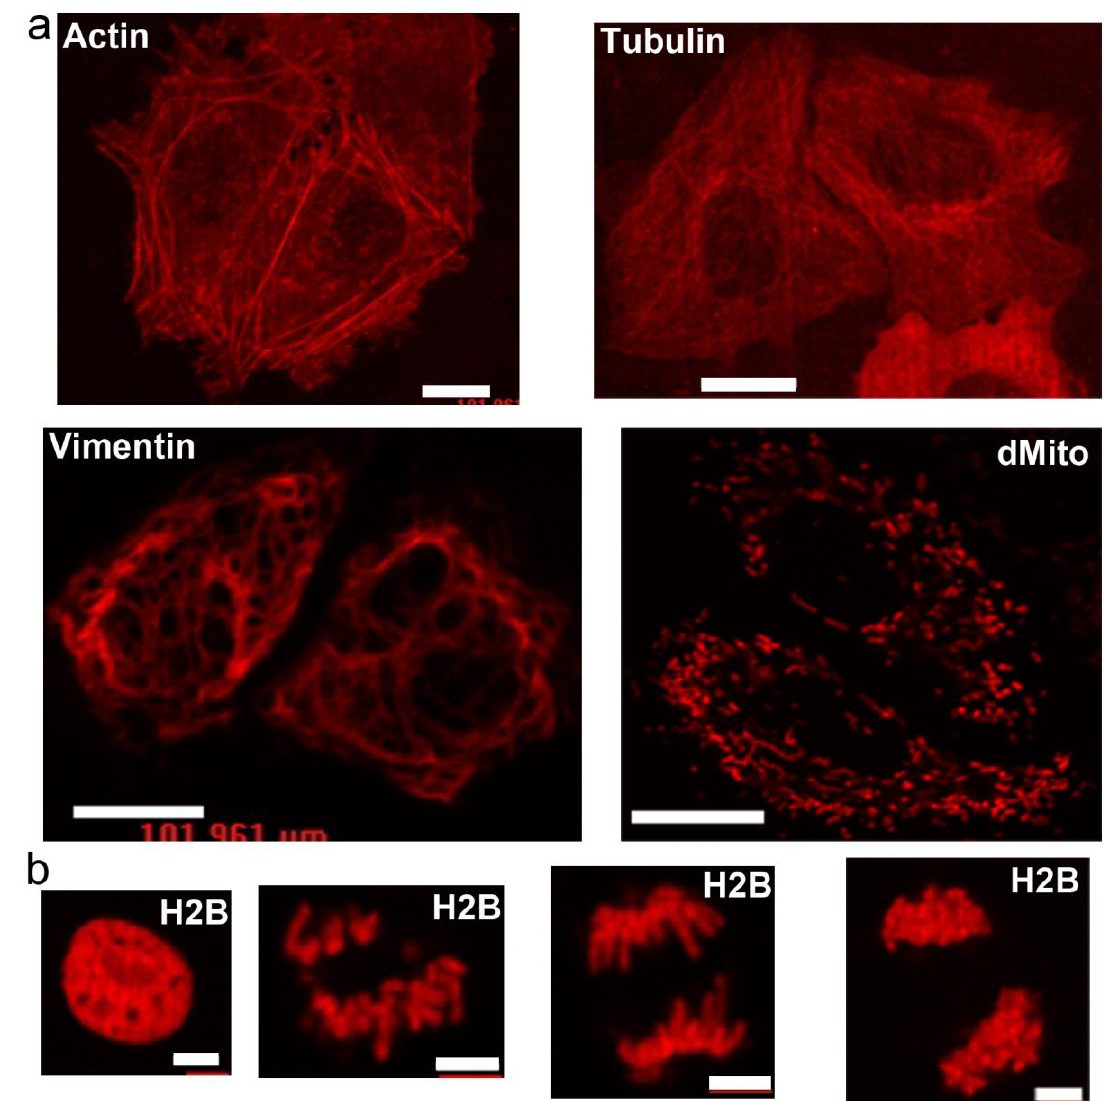
Figure 4. Localization of the LSSmScarlet protein in different fusions in mammalian cells. ( a ) Confocal images of HeLa cells expressing the actin-LSSmScarlet, tubulin-LSSmScarlet, vimentin-LSSmScarlet and dMito-LSSmScarlet fusions. Scale bar, 100 µm. ( b ) Confocal images of non-dividing and dividing HeLa cells expressing the H2B-LSSmScarlet fusion. Scale bar, 50 µm.